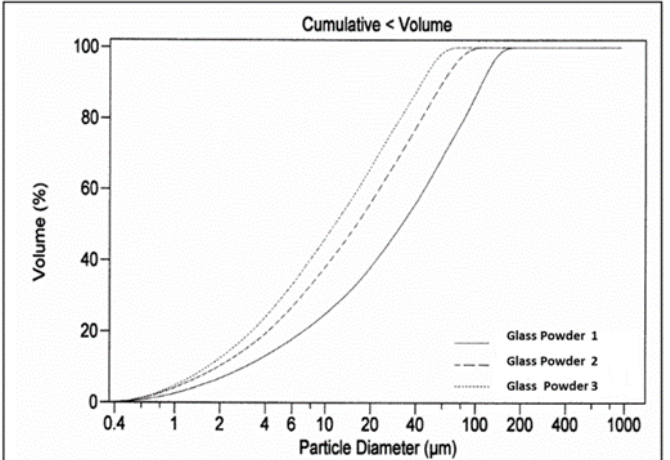
Figure 1. Distribution of the accumulated granulometry of the 3 batches of glass powder [32].